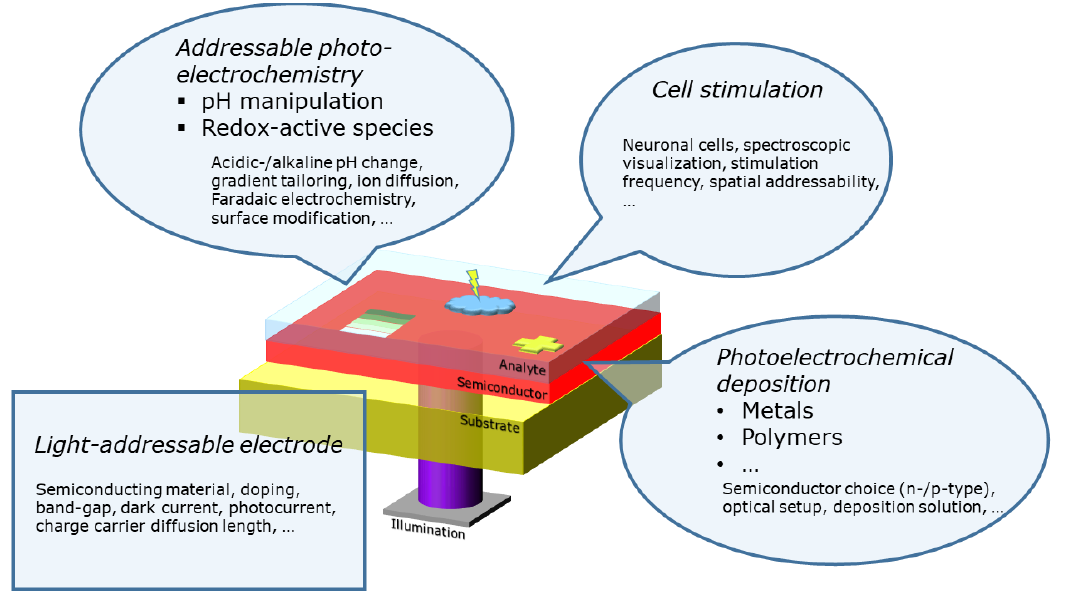
Figure 2. Overview of the presented topics in this review article: In contrast to well-known electrodes made of noble metals, light-addressable electrodes with a semiconductor electrode material can be addressed with a light source. Addressable photoelectrochemistry, cell stimulation, and photoelectrochemical deposition are introduced as possible